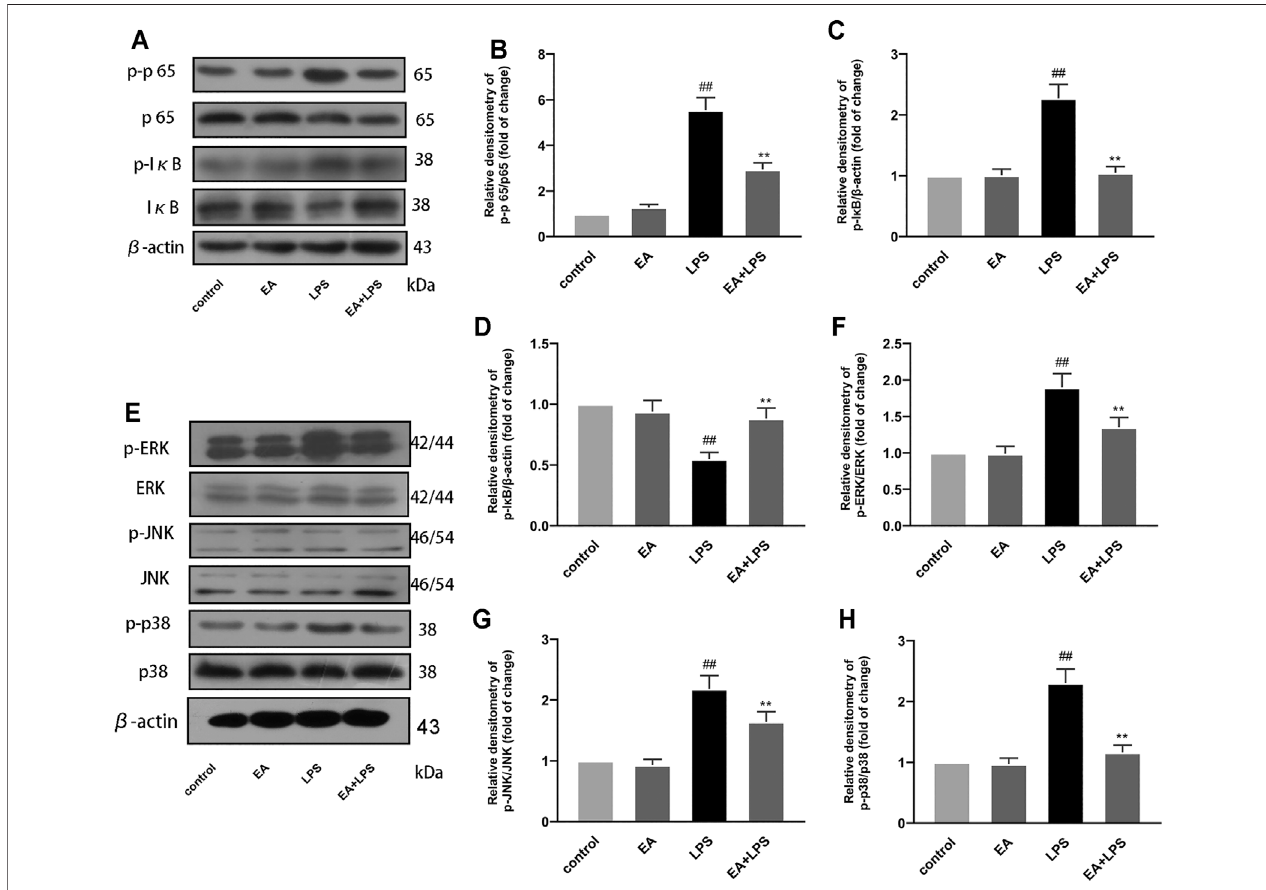
FIGURE 4 | EA inhibits NF- κ B and MAPK signal pathway. We treated BV2 cells for 1 h with EA (16 μ M) and stimulated for 2 h with LPS (100 ng/ml). Then we examinedtheeffectofEAontheprotein expressionofp-p65,p65 (A,B) ,p-I κ B (A,C) ,I κ B (A,D) ,p-ERK, ERK (E,F) ,p-JNK,JNK (E,G) ,p-p38, p38 (E,H) ,and β -actin via Western blot experiment. Results are represented as means ± SD ( n (cid:1) 4). ## p < 0.01 vs. control group. **p < 0.01 vs. LPS-exposed